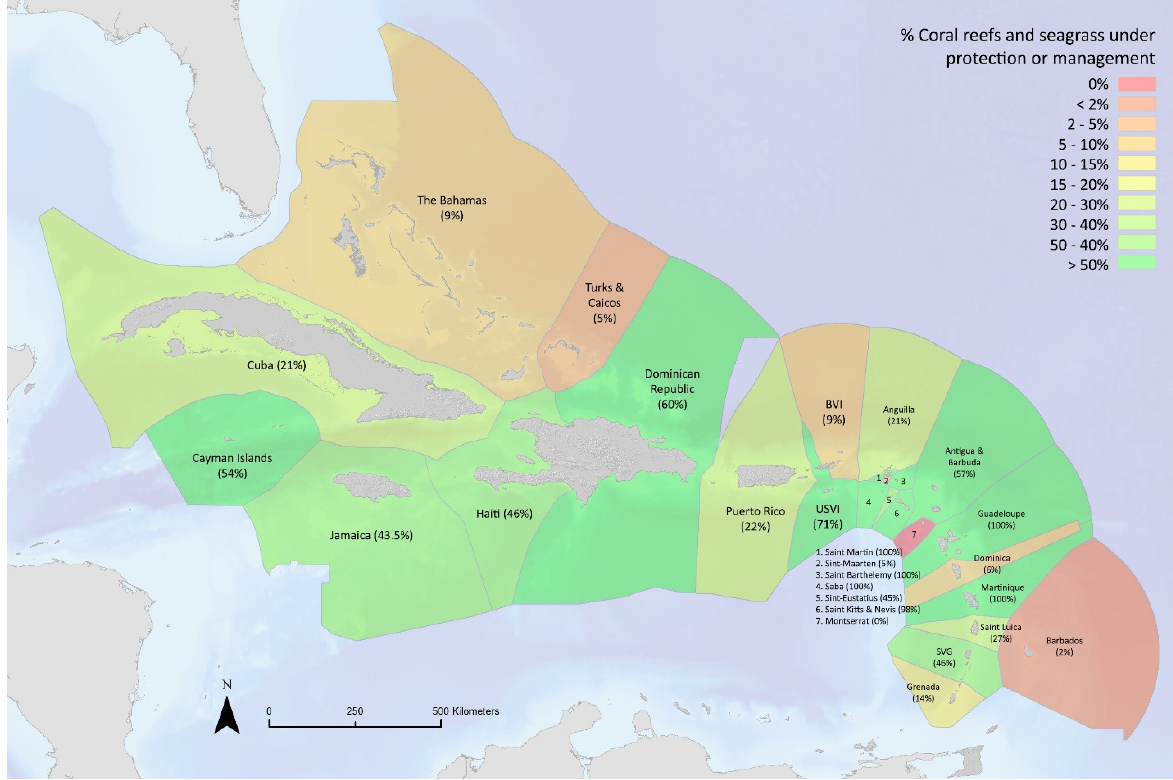
Figure 14. Percentage of coral reef and seagrass within the shallow zone (<30 m) under protection or management regardless of management objectives by jurisdiction. The shaded areas represent the Exclusive Economic Zone (EEZ), and percentages are calculated not on total marine space for each jurisdiction, but the total area of shallow coral reef and seagrass area within each jurisdiction’s declared protected or managed area boundaries.